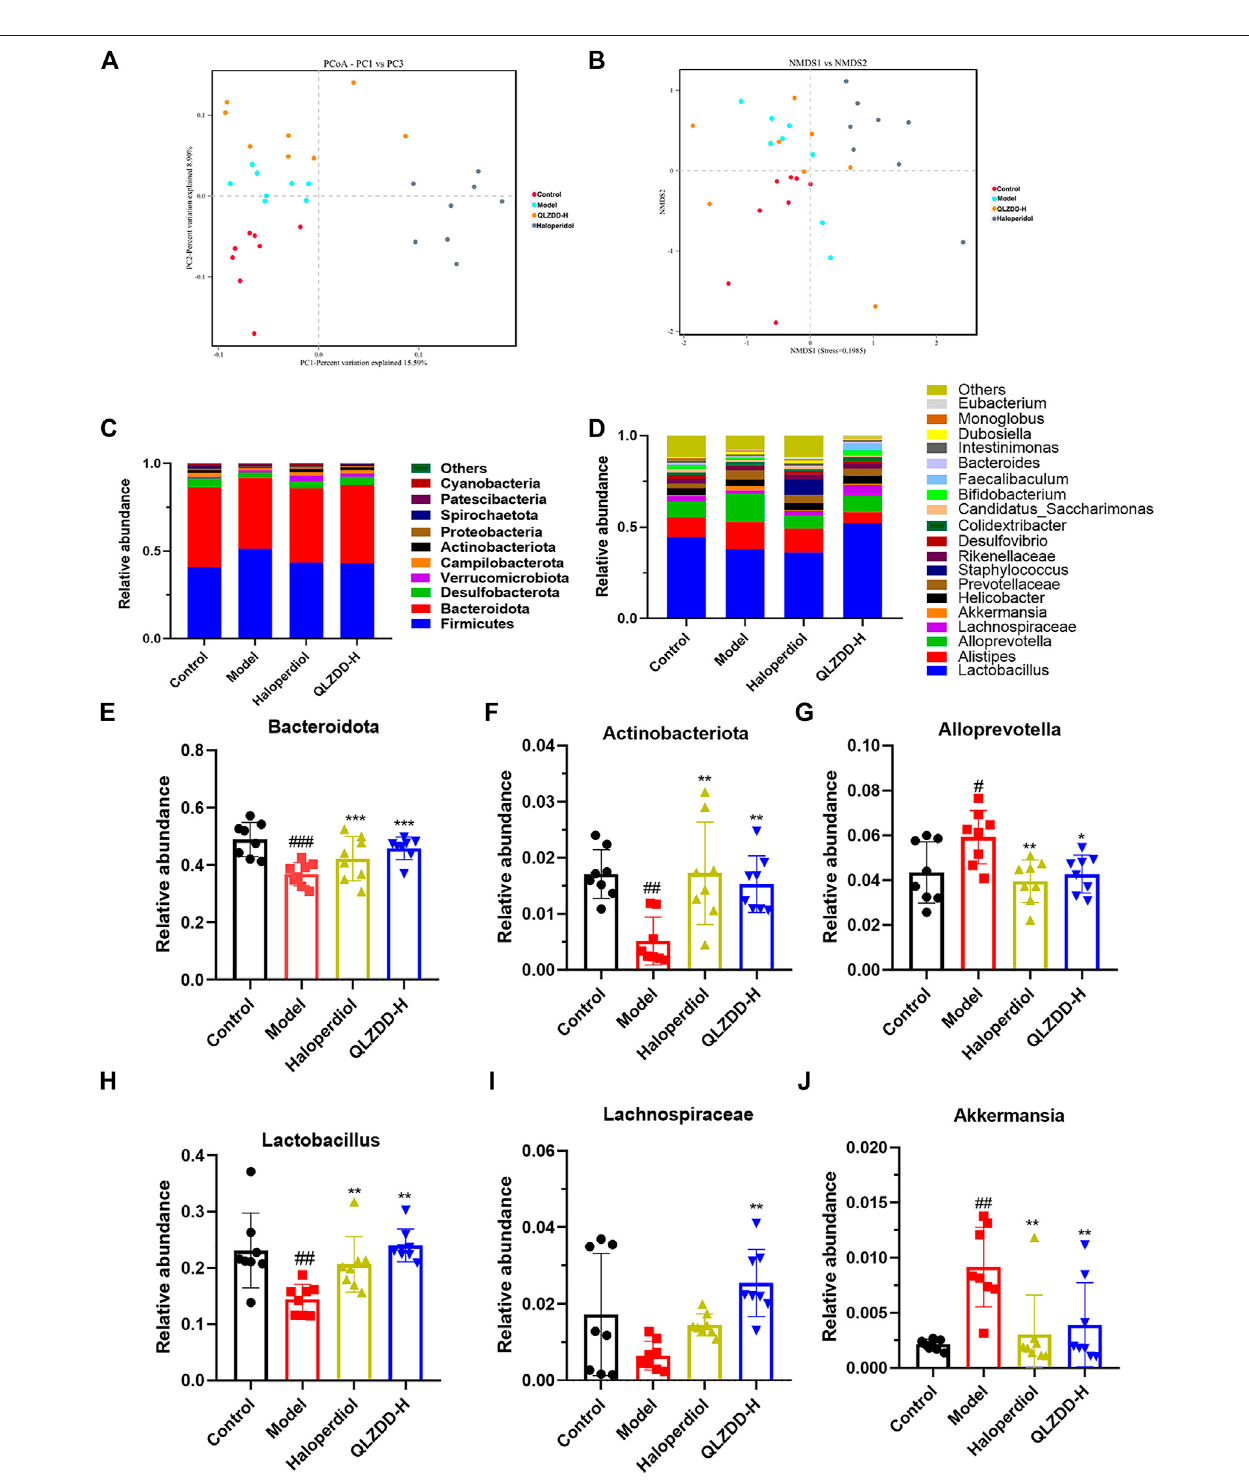
FIGURE7| Theeffect ofQLZDD on thecompositionofgut microbiota. (A) The PCoA ofsamples at theOTU level, (B) theNMDS ordination ofsamplesat theOTU level, (C) therelativeabundanceofthe10mainphyla, (D) therelativeabundanceofthe20maingenera, (E, F) thechangesindifferentmicro fl oraatthephylum level,and ( G – J ) the changes in different micro fl ora at the genus level. All data were expressed as mean ± SD ( n = 8 mice). One-way ANOVA was used to compare the data of the QLZDD groups with the data of the control group. ## p < 0.001 in comparison with the model group. * p < 0.001.